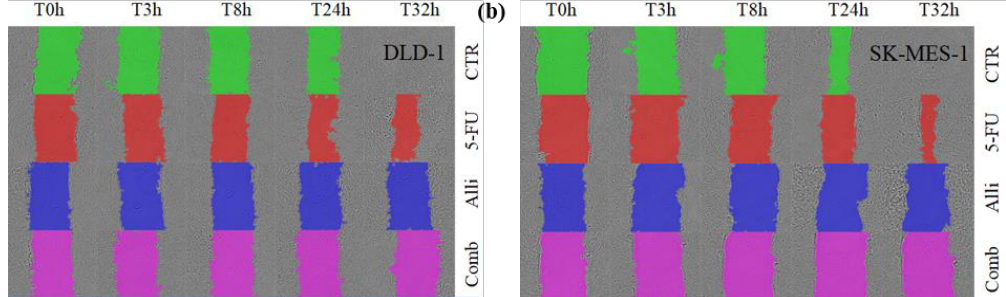
Figure 5. The investigation of the migration and colony formation capacity after allicin, 5-FU, and co-treatment. ( a ) DLD-1 cells are sensitive to allicin and co-treatment, while the 5-FU has a limited effect on cell migration. ( b ) SK-MES-1 cells are sensitive to combined treatment and allicin, with 5-FU being unable to totally inhibit migration. Abbreviations: CTR, control group; 5-FU, half of the 5-fluorouracil IC 50 -treated group; Alli, half of the Allicin IC 50 -treated group; Comb, the co-treatment group. Cell migration was inhibited by all treatments, with the combined treatment being the most cell migration in both tumor cell lines. Colony formation was inhibited by all treatments, indicating